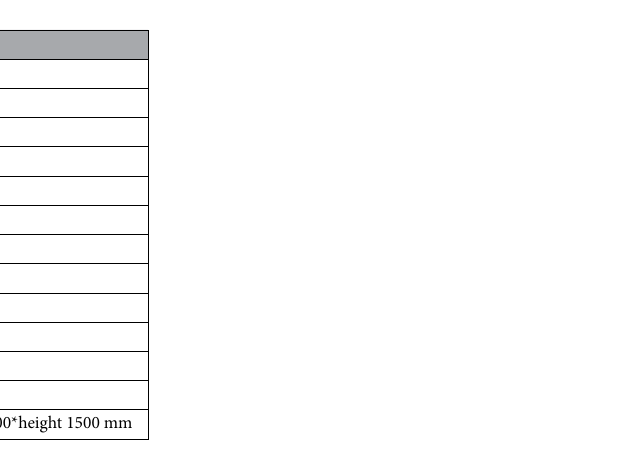
Table 1. Configuration of the